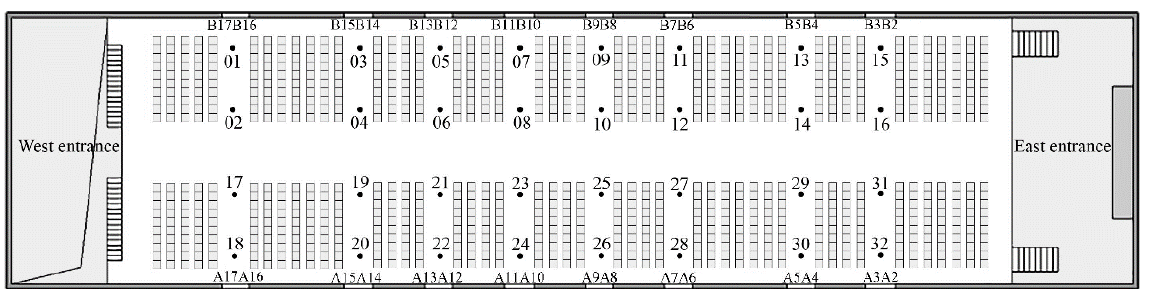
Figure 5. Layout of measuring points.